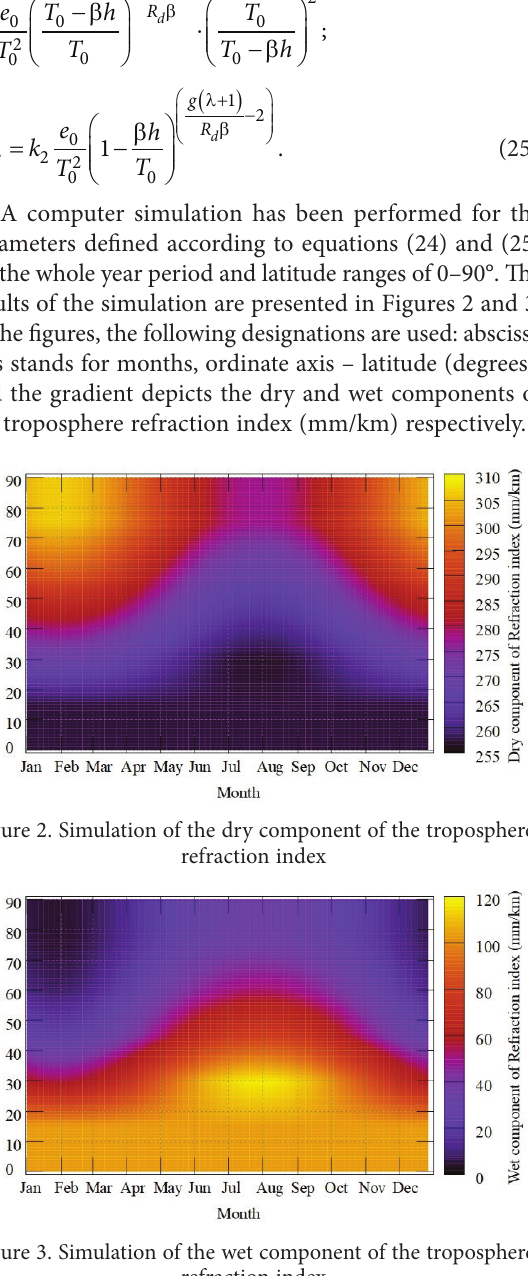
Figure 3. Simulation of the wet component of the troposphere refraction